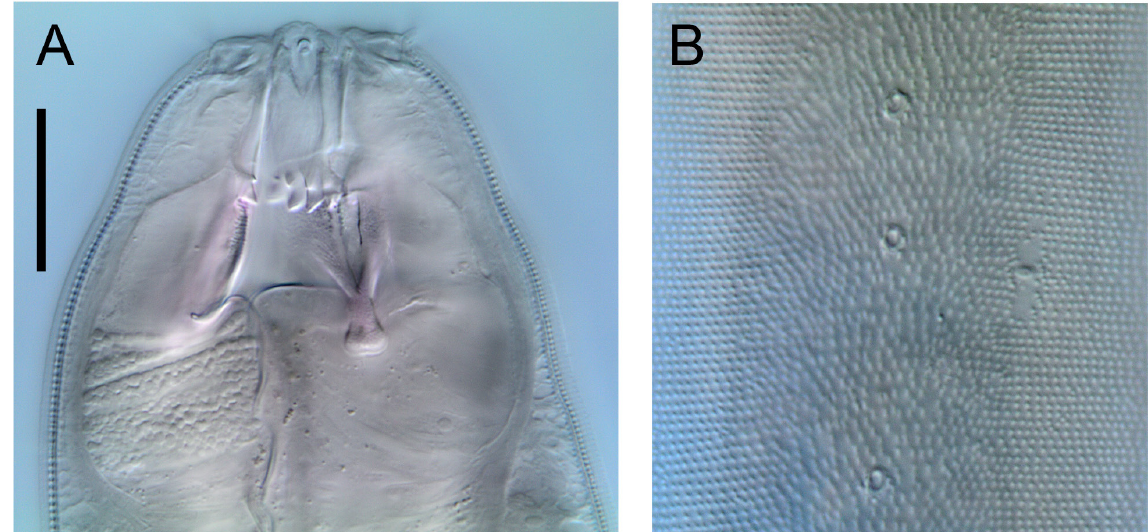
Fig. 10. Cobbionema trigamma sp. nov. Light micrographs. A . Buccal cavity of holotype. B . Cuticle of holotype, showing cuticle pores. Scale bar: A = 25 µ m; B = 12